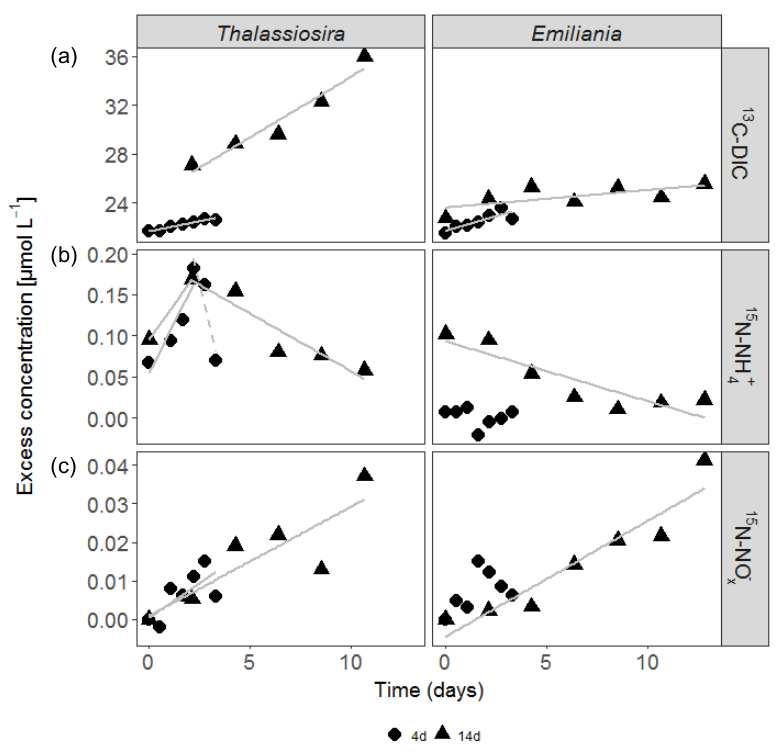
Figure 2. Accumulation of 13 C-DIC (a) , 15 N-NH + linear regressions are shown in full grey lines. The dashed grey line in the 15 N-NH + a non-significant regression based on 3 points ( p = 0 . 2).